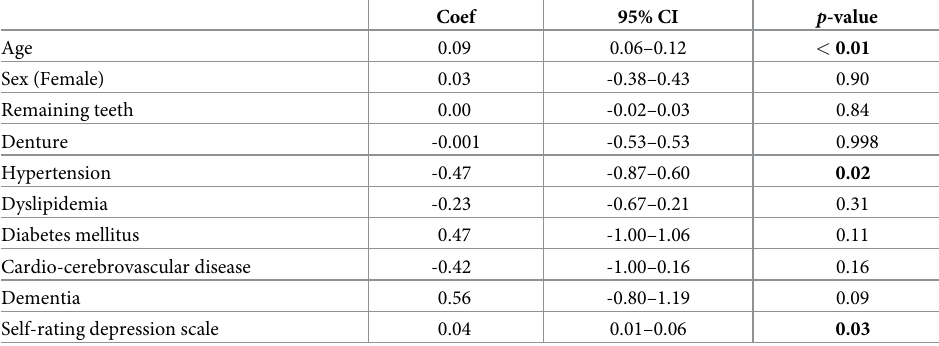
Table 2. Multivariate ordered logit regression analysis for robust, pre-sarcopenia, and sarcopenia (n =